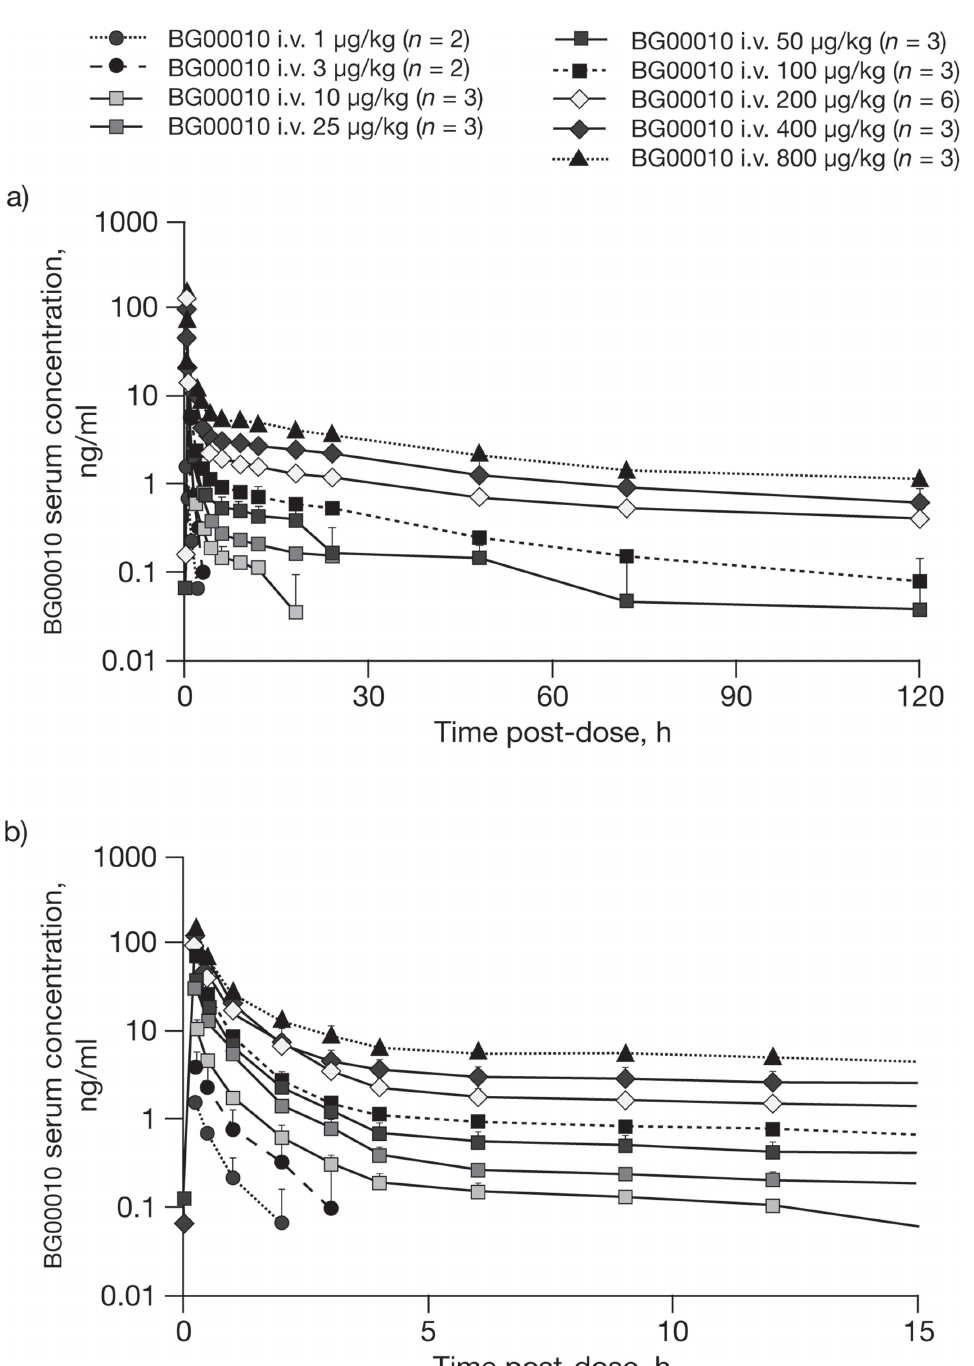
Fig 5. BG00010 serum concentrations over time. Mean (standard deviation) BG00010 serum concentrations over (a) 120 h and (b) 15 h (expanded time axis) following i.v. administration of BG00010. Note that data were only available for two subjects treated with BG00010 25 μ g/kg at 9, 12, 18 and 48 h. Where data points are not shown, the mean BG00010 serum concentration was equal to 0.00 ng/ml. h, hours; i.v., intravenous.